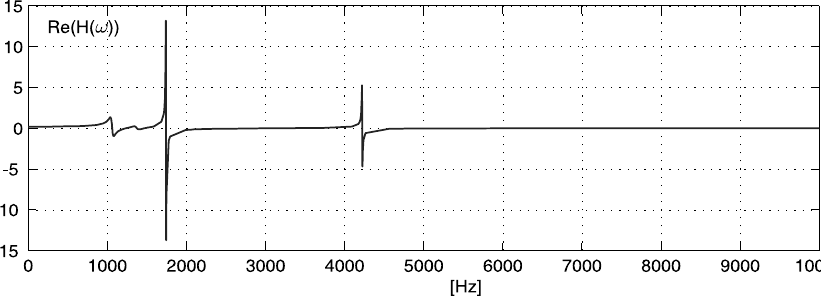
Fig. 6. Real part of the transmissibility H ( ω ) .